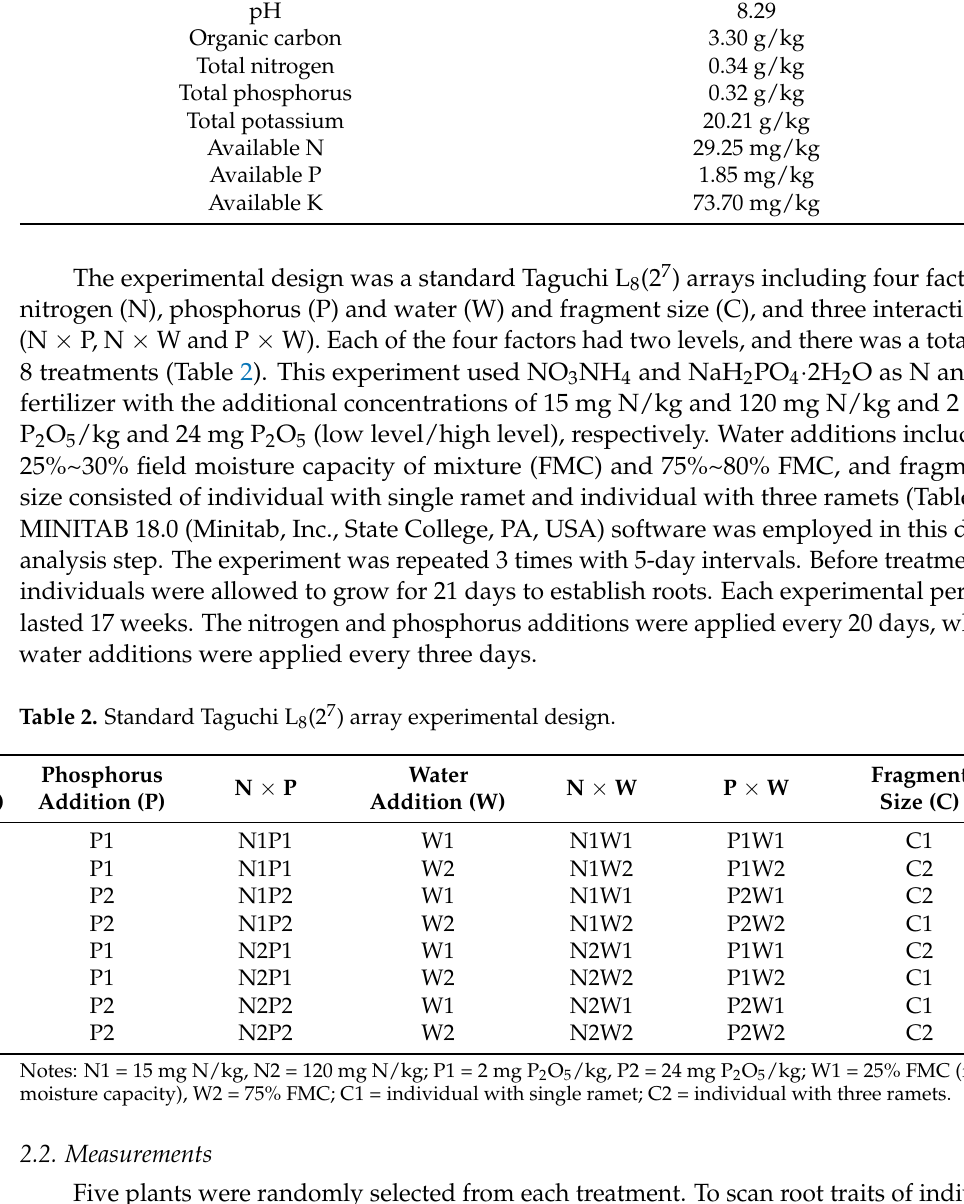
Table 1. Chemical properties of soil used in the experiment. Properties